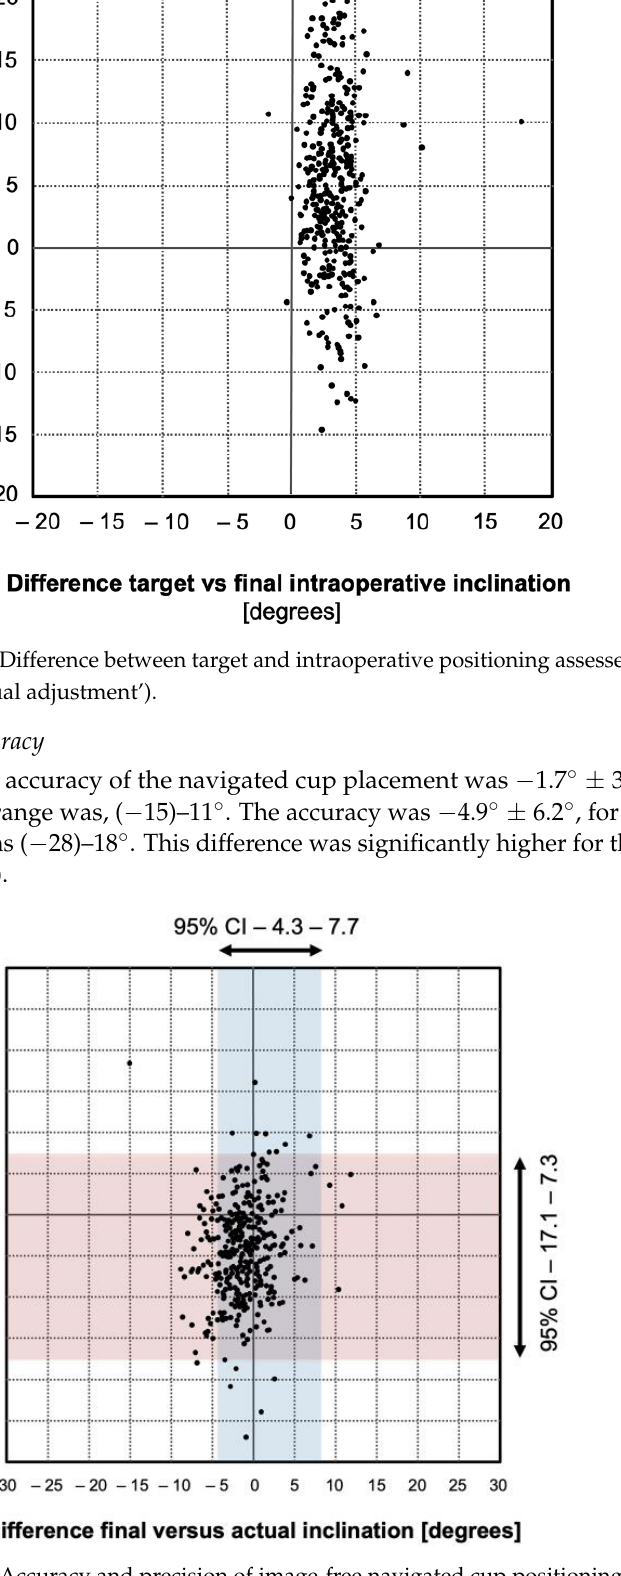
Figure 4. Accuracy and precision of image-free navigated cup positioning. Each point represents one cup. The difference between final and actual inclination and anteversion given as dots in the diagram.